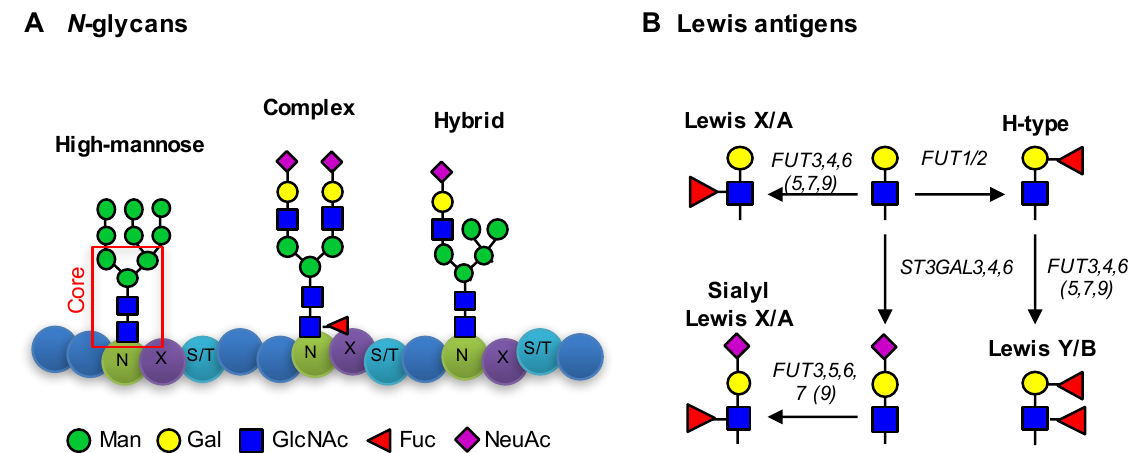
Figure 1. N -glycans and Lewis antigens. ( A ) N -glycans are attached to an asparagine (N) in the consensus sequence N-X-S/T with X any amino acid except proline, followed by serine (S) or threonine (T). Main monosaccharides involved in N -glycosylation are mannoses (Man), galactoses (Gal), N -acetylglucosamine (GlcNAc), fucoses (Fuc), and N -aceylneuraminic acid (NeuAc). N -glycans share a common core-structure, consisting of two GlcNAc and three Man. Depending on the elongation, three N -glycan types are differentiated, as follows: i) High-mannose type N -glycans, ii) complex-type N -glycans, and iii) hybrid-type N -glycans. The illustrated glycans represent examples. The number of monosaccharides added can vary and complex type glycans can exhibit more than two antennae. A detailed description of N -glycosylation is given by Stanley [4]. ( B ) Depiction of different Lewis-antigens and involved glycosyltransferase genes. Fucosyltransferase genes FUT3,4,5,6,7,9 are involved in fucosylation α 1,3- and α 1,4-fucosylation of antennae GlcNAc, while FUT1,2 attach α 1,2-fucosylation to Gal-residues. Activity of several α 2,3-sialyltransferase ( ST3GAL genes) attach NeuAc residues to galactoses to form sialyl Lewis